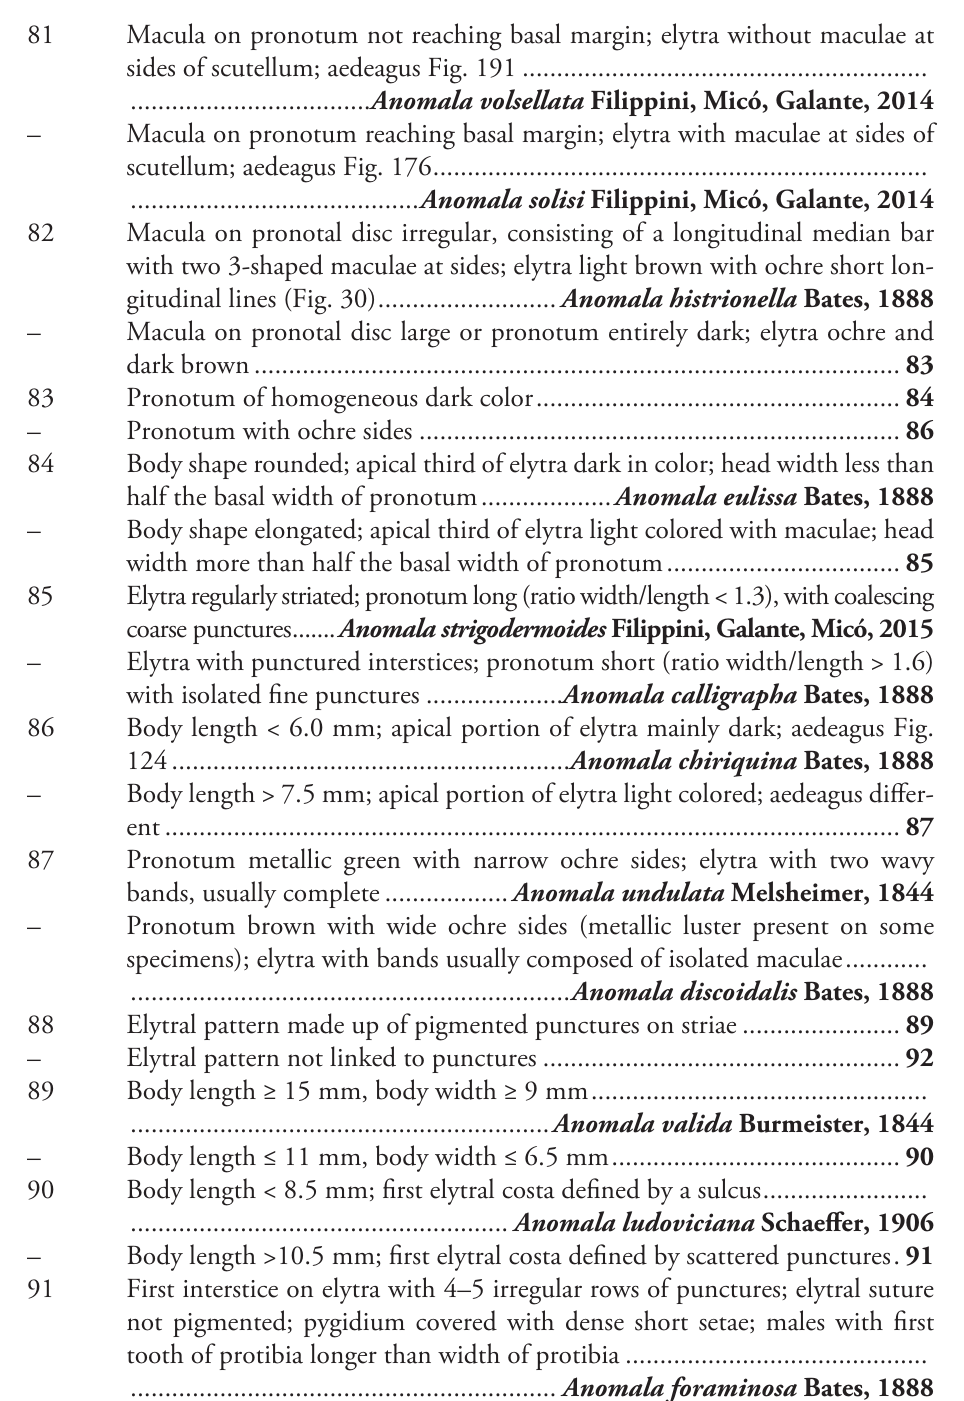
Macula on pronotum not reaching basal margin; elytra without maculae at